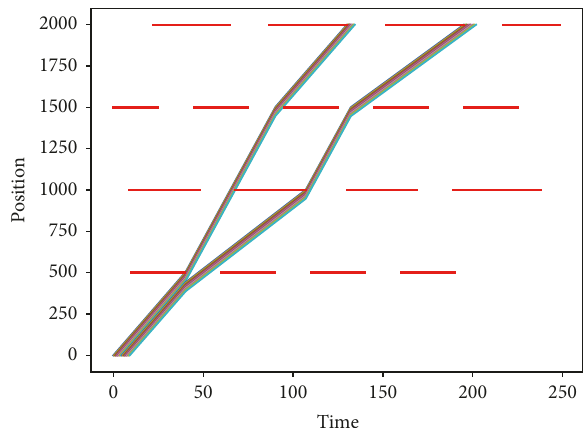
Figure 8: Trajectory of vehicles of platoon with separation strategy (minimum fuel consumption).